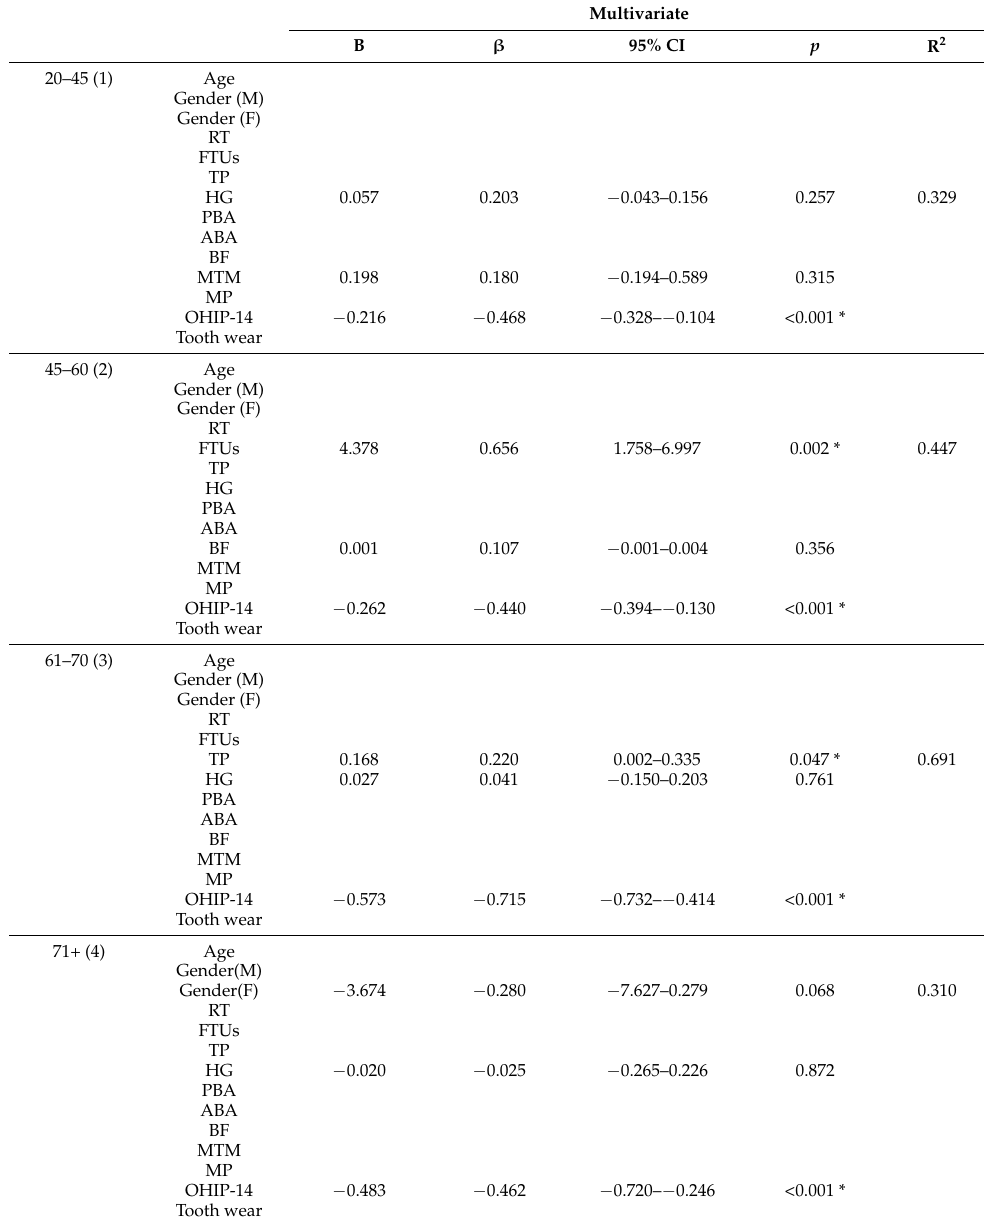
Table 5. Multiple linear regression analysis of factors associated with